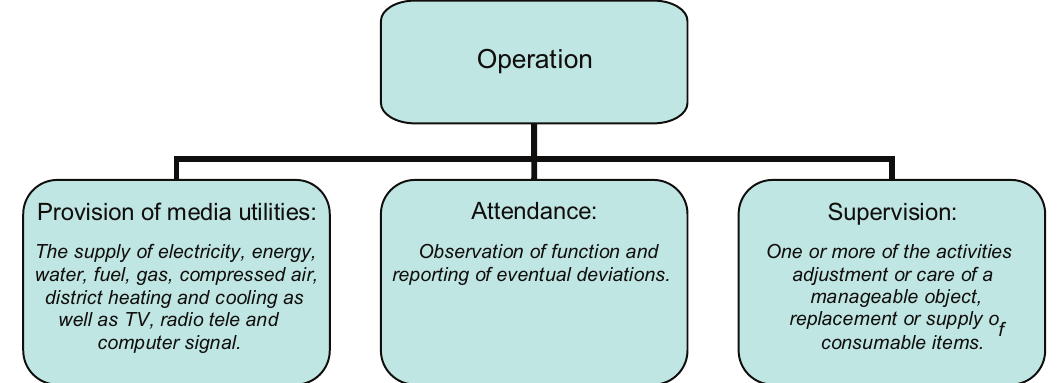
figure 1. operation types in aff